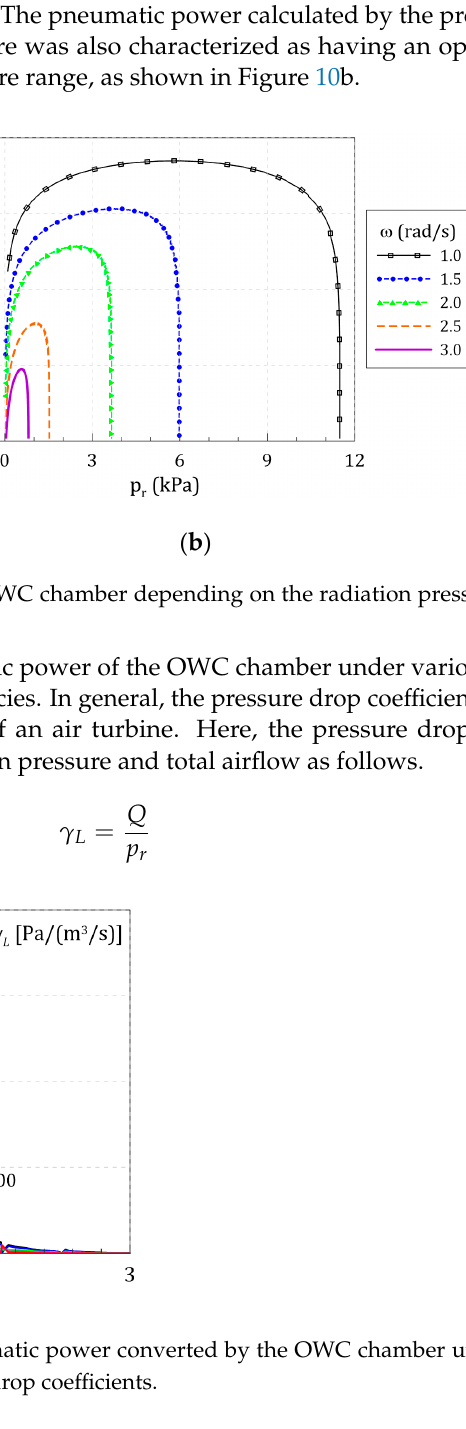
( b ) Figure 9. Longitudinal free-surface profiles of sloshing mode inside the OWC chamber: ( a ) first longitudinal sloshing mode, ω = 1.8 rad/s; ( b ) second longitudinal sloshing mode, ω = 2.5 rad/s; (solid line: crest, dashed line: trough).